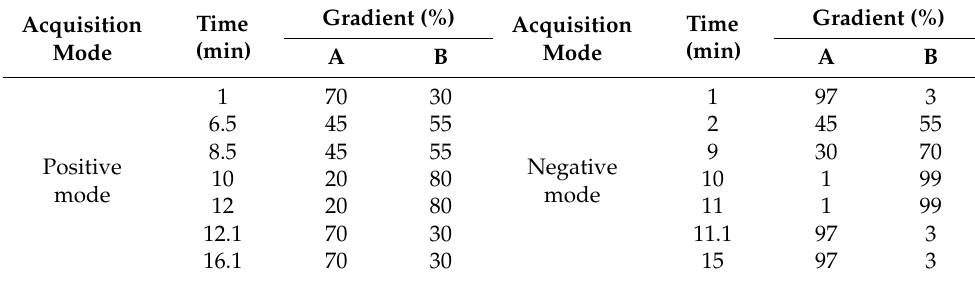
Table 1. Gradient elution